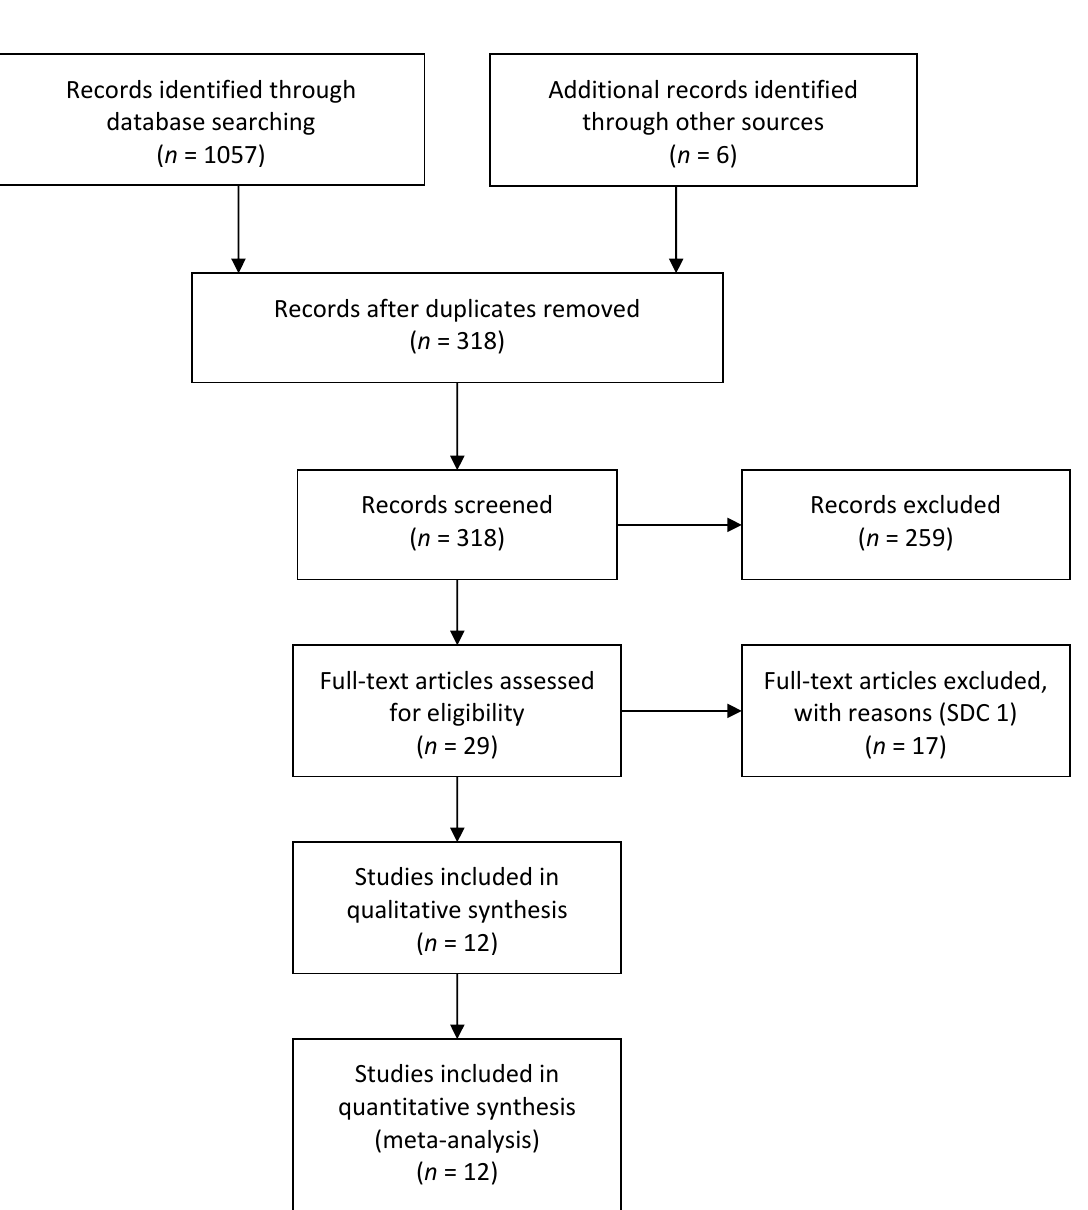
Figure 1. Prisma flow diagram of selected